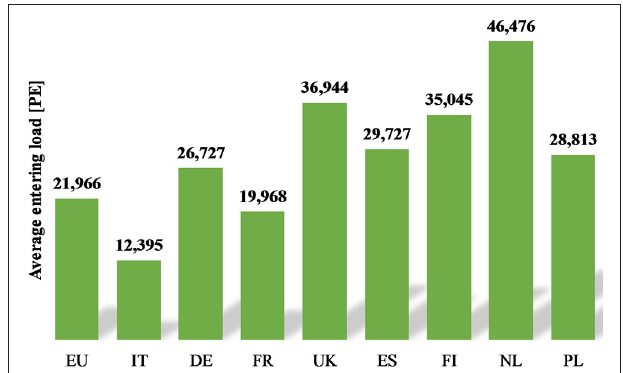
WWTPS DISTRIBUTION IN